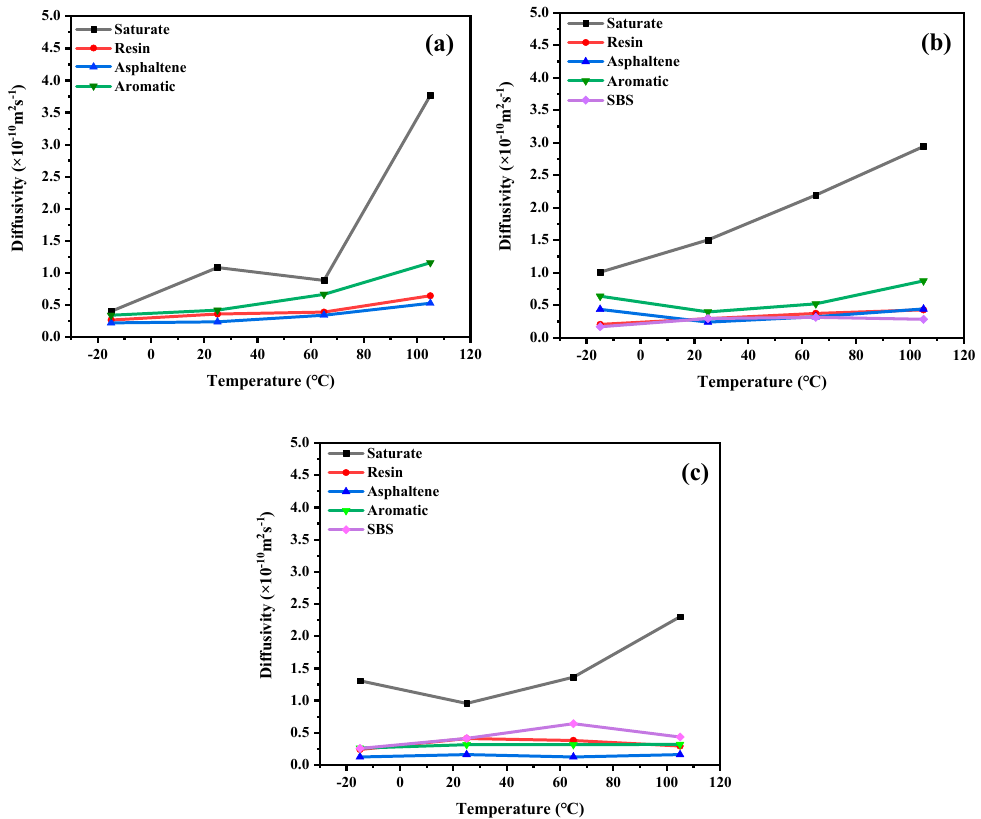
Figure 10. Diffusion coefficients of asphalt samples with different SBS contents at different temperatures. ( a ) 70# asphalt; ( b ) PG76-22 modified asphalt; ( c ) S-HV modified asphalt.